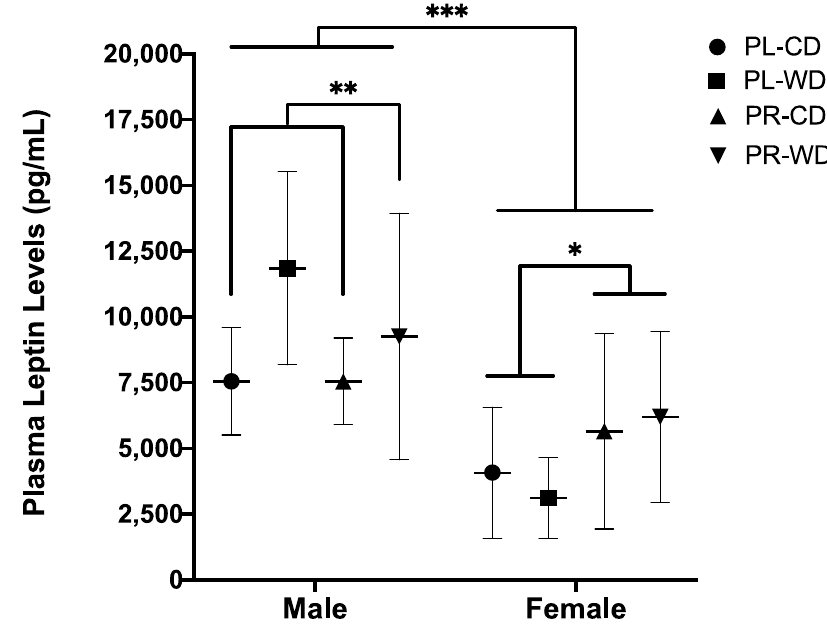
Figure 6. Plasma leptin levels (pg / mL) in males and females by treatment and diet condition. Data expressed as M ( SD ). * p < 0.05, ** p < 0.01, *** p < 0.001. PL: placebo; PR: probiotic; WD: Western diet; CD: control diet. Figure 7A) and daily calorie intake ( r s = 0.75, p < 0.001, N = 62; Figure